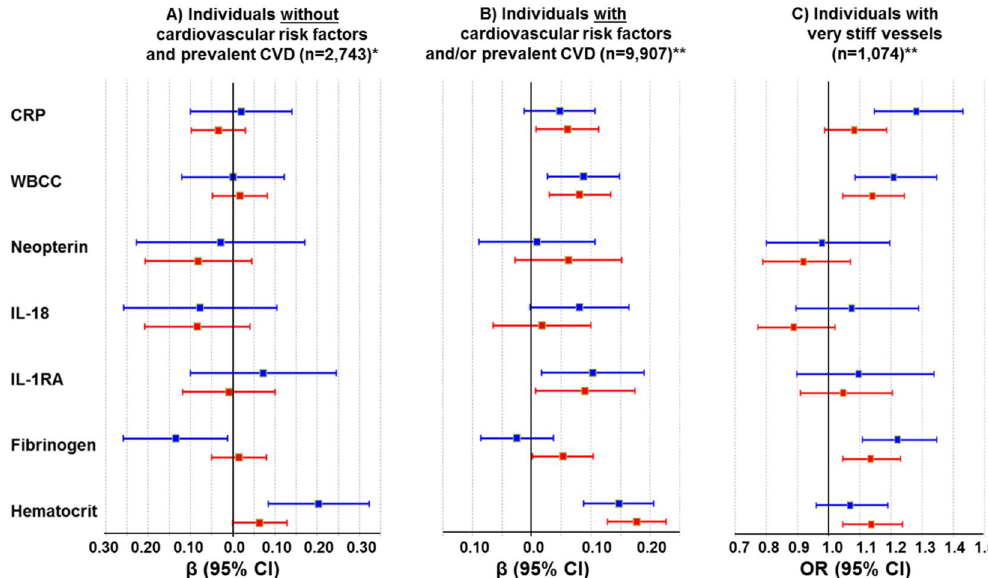
Figure 4. Relation of Stiffness Index with Markers of Inflammation and Hemostasis According to Cardiovascular Risk Profile. Estimates for men are presented in blue, and for women in red. Linear regression analysis with stiffness index as dependent variable was applied for samples ( A and B ). Data represent β -estimates per 1-SD increase in biomarker concentration with 95% CIs. Logistic regression analysis with presence of very stiff vessels as dependent variable (as dichotomous trait: very stiff versus measurable SI) was applied for sample ( C ). Data represent ORs per 1-SD increase in biomarker concentration with their 95% CIs. * Model adjusted only for age, systolic and diastolic blood pressure, since cardiovascular risk factors and cardiovascular disease are not present in this sample. ** Models adjusted for age, traditional cardiovascular risk factors (systolic and diastolic blood pressure, diabetes mellitus, obesity, smoking, dyslipidemia, FH on MI/stroke) and blood-pressure lowering medication. OR stands odds ratio, CI for confidence interval, CRP for C-reactive protein, WBCC for white blood cell count, IL-18 for interleukin-18, IL-1RA for interleukin-1 receptor antagonist, and CVD for cardiovascular